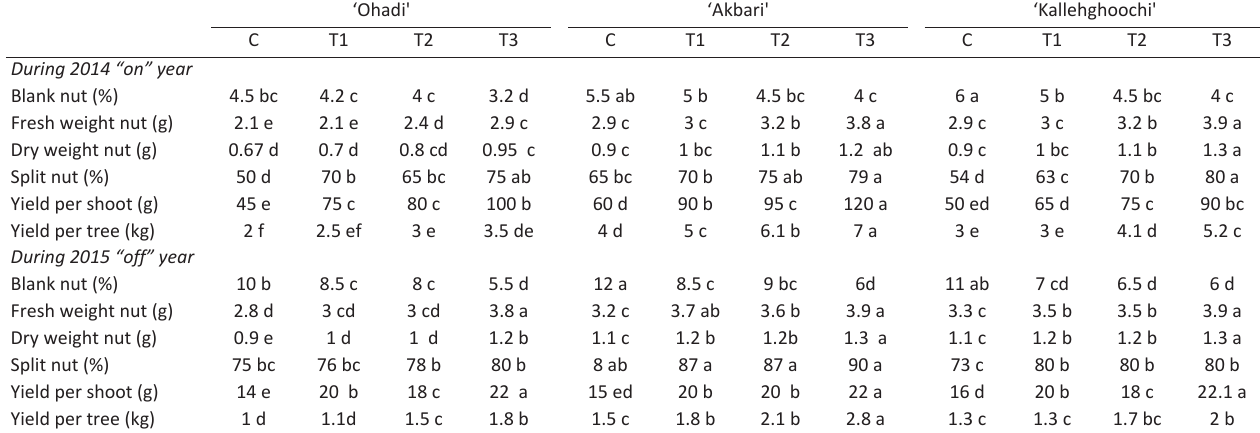
Table 3 - Interaction of stage of brassinostroides application and cultivar for blank, split, fresh and dry weight of nut, and yield per shoot of pistachio in two years